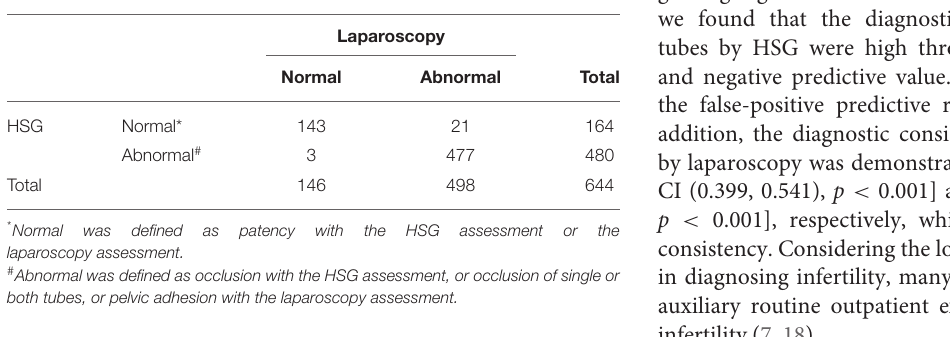
TABLE 5 | Consistency between laparoscopy and HSG in patients diagnosed with hydrosalpinx by HSG n (%). Hydrosalpinx by Pelvic laparoscopic adhesion